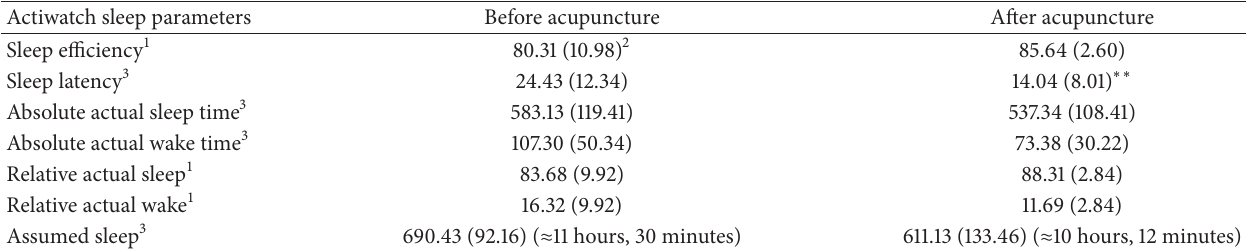
Table 2: Actiwatch results for our patient with chronic schizophrenia before and after acupuncture